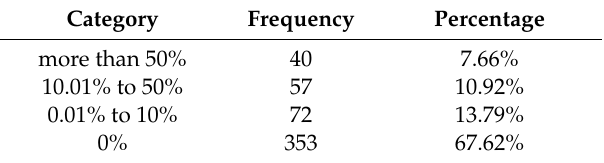
Table 6. Percentage of dog dreams that include threatening dogs ( n = 522).